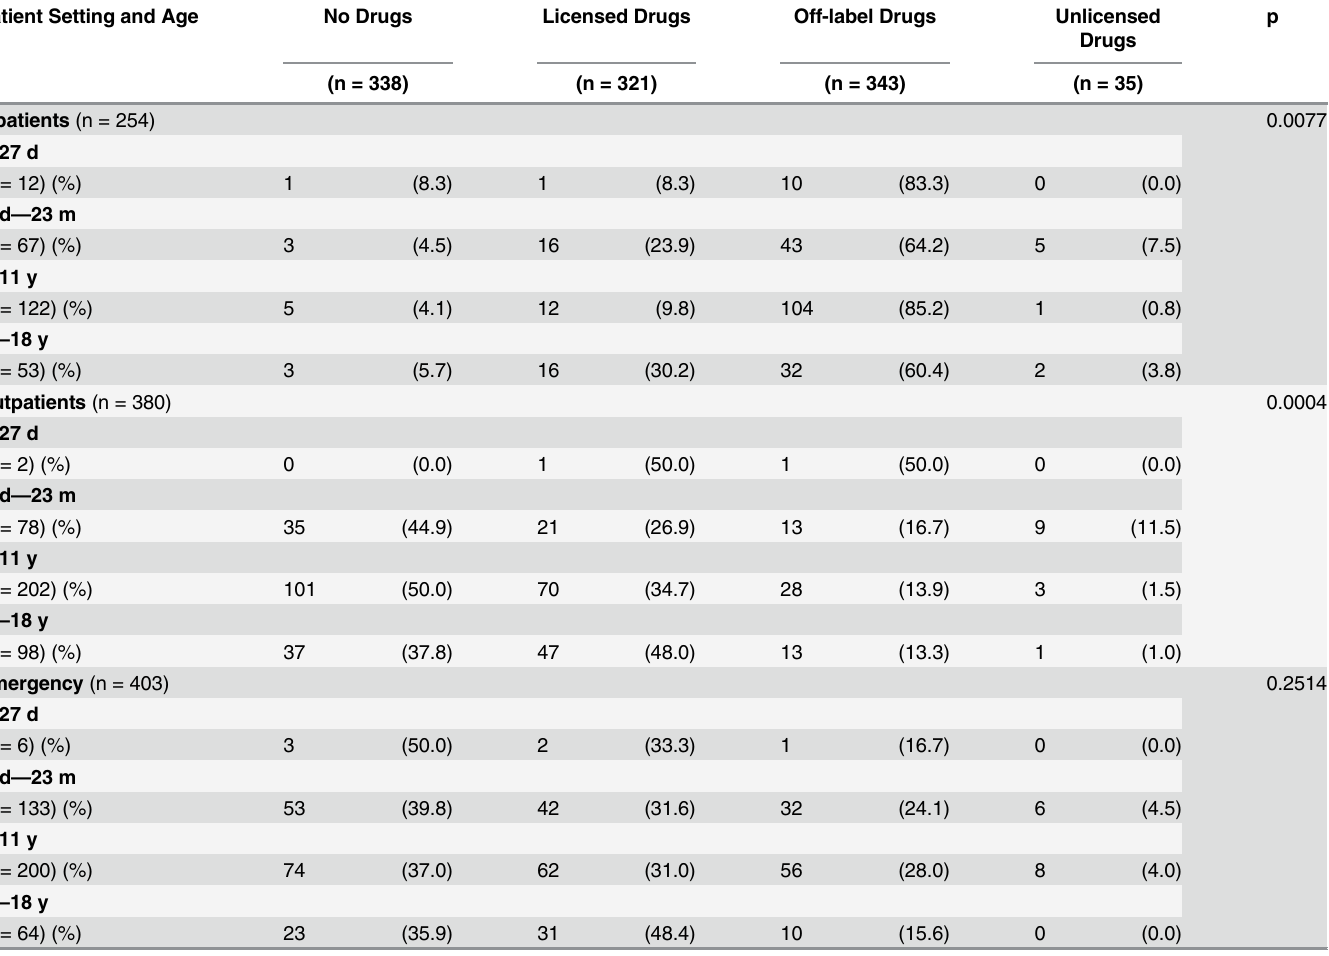
Table 2. Number and percentage of inpatients, outpatients and emergency department patients in various age groups prescribed no drugs, licensed, off-label or unlicensed drugs. Patient Setting and